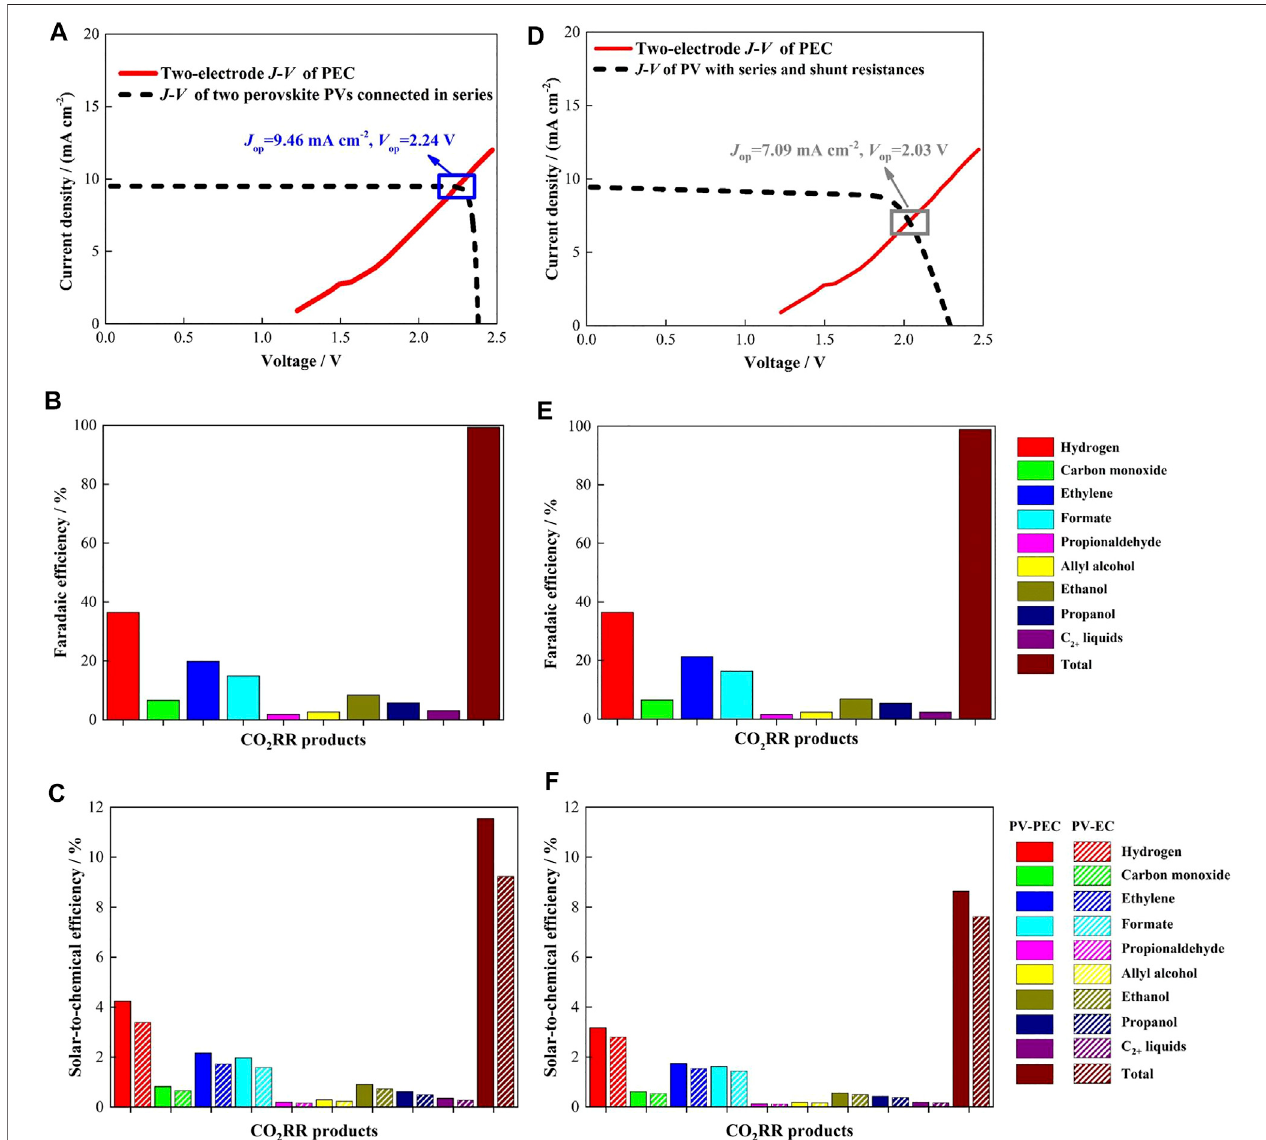
FIGURE2| PerformanceofPV-PECCO 2 RRand thecounterpartPV-ECCO 2 RR. (A) J - V curveoftwoperovskitesolarcellsconnectedinseriesand two-electrode J - V curve ofPEC cell withthephotocathode comprisingac-Siphotoabsorberand ahigh loading ofnanostructured Cu-Agbimetallicco-catalyst. (B) Faradaicef fi ciency of each product for both PV-PEC CO 2 RR and the counterpart PV-EC corresponding to the operating point (the operating point for PV-EC was obtained from Supplementary Figure S2 ). They have the same product distribution. (C) STC ef fi ciency of PV-PEC CO 2 RR and the counterpart PV-EC for each product and all products.Thevalueswerecalculatedusing Eq.1 forPV-PECand Eq.2 forPV-EC. Inputparametersfor Eqs1 , 2 wereobtainedfrom Figures2A,B . (D) – (F) Achievable STCef fi ciencyofPV-PECCO 2 RR.Inthiscase, Eq.4 wasusedtodescribethePVcellandtheinputparametersfor Eqs1 , 2 wereobtainedfrom Figures2D,E .PV-PEC CO 2 RR still has higher STC ef fi ciency than PV-EC because they are driven by the same PV cell.